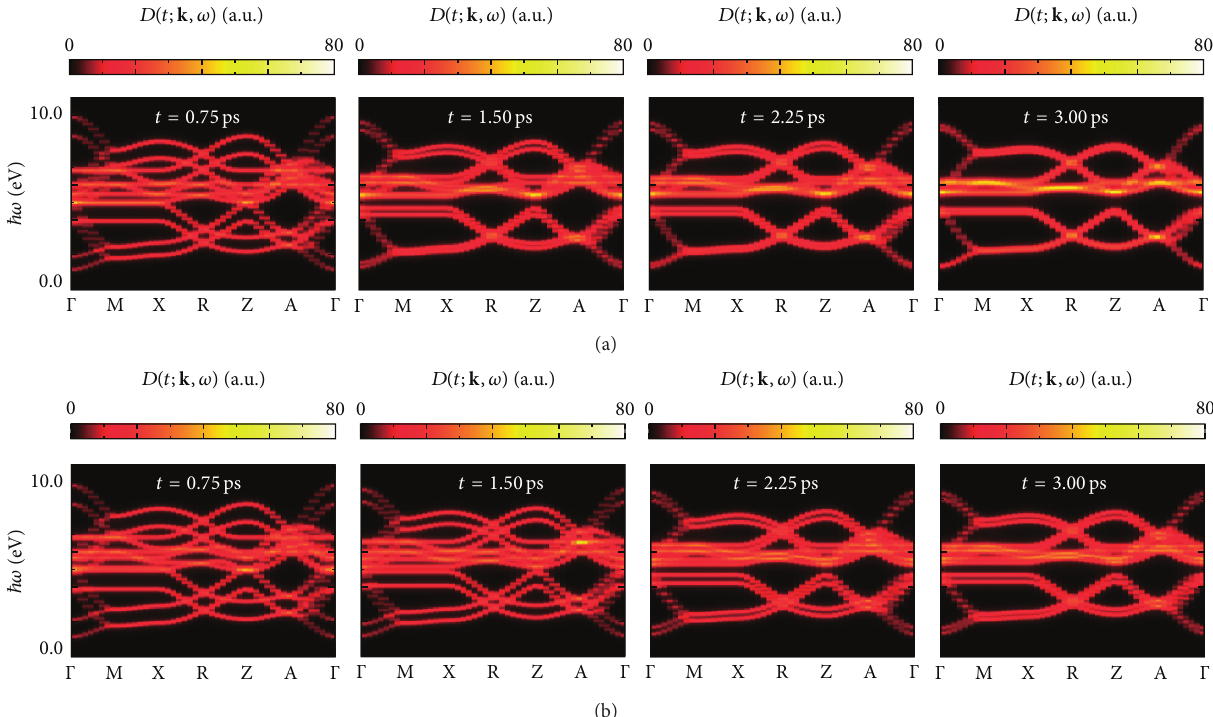
Figure 8: Snapshots of the one-particle spectral function 𝐷(𝑡; k ,𝜔) every time we apply a pump laser pulse in the form of (15) in the cases of ‖ a (the upper panels) and A ‖ c (the lower A 0 0